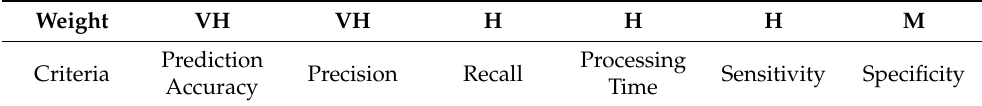
Table 4. Preference criteria for sensitivity analysis.